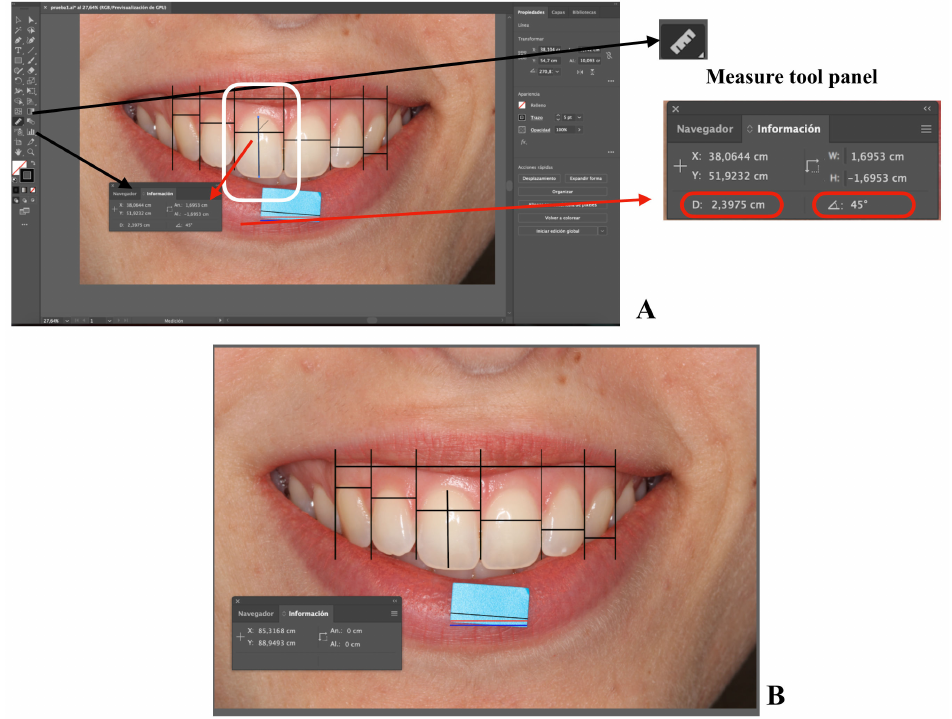
Figure 5. Screenshots of the sample image with the different steps of the protocol. Screenshots of the sample image with the different steps of the protocol ( A , B